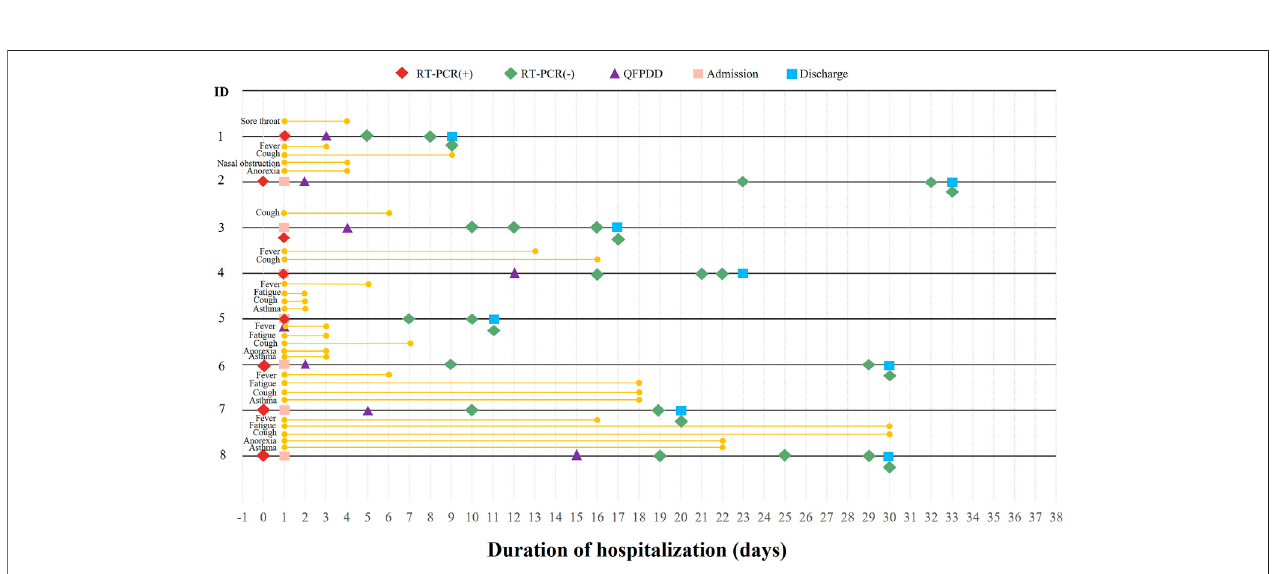
FIGURE 2 | Detailed course of eight COVID-19 cases during